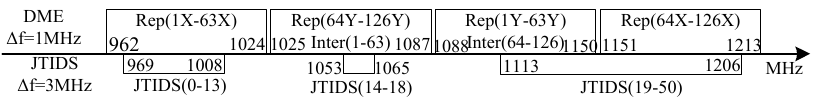
Figure 3. The frequency distribution for DME and